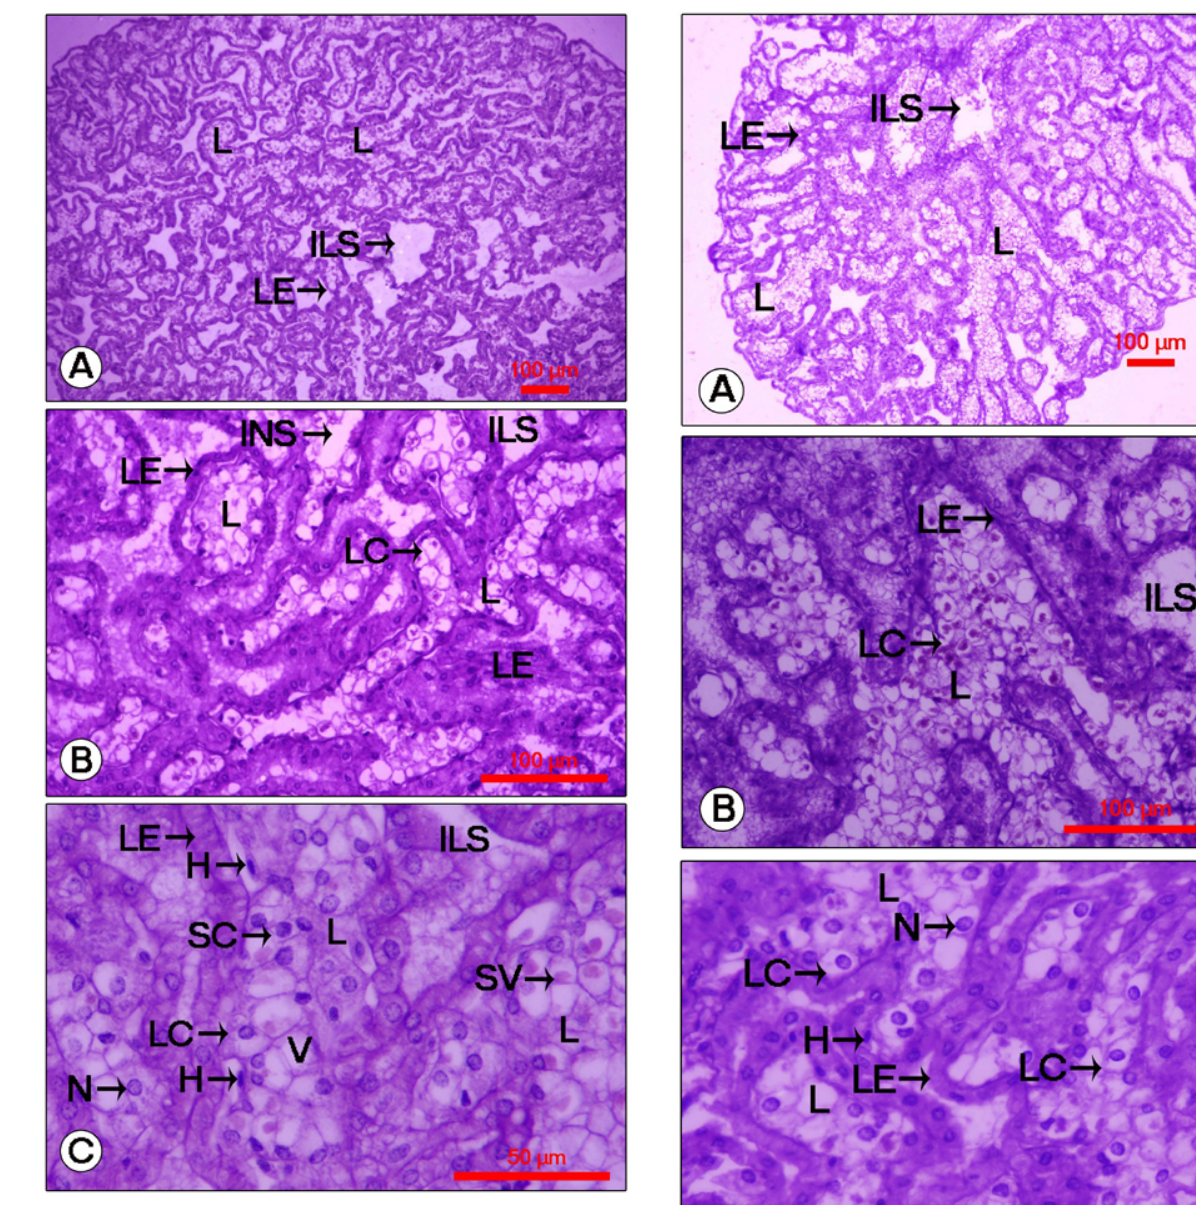
Figure 4. Light micrograph of histology of Y-organ of crabs treated with MF during C3 stage in Travancoriana schirnerae. ( A, B ) Large, loosely arranged, branched lobules with reduced intra- and inter-lobular spaces at low and high magnification. ( C ) Enlarged view of lobules with compactly packed gland cells, secretory vesicles, vacuoles and hemocytes. H: Hemocyte; ILS: Inter-lobular space; INS: Intra-lobular space; L: Lobule; LC: Larger cell; LE: Lobular epithelium; N: Nucleus; SC: Smaller cell; SV: Secretory vesicle, V: Vacuole.